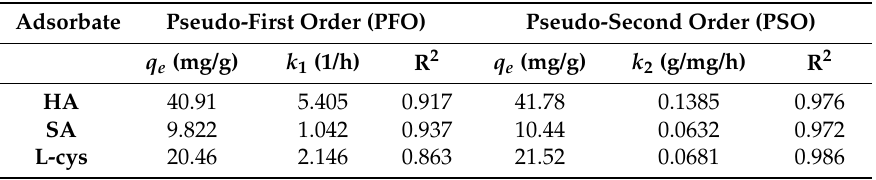
Table 2. Kinetic parameters used to describe the adsorption of organic ligands on ZnO